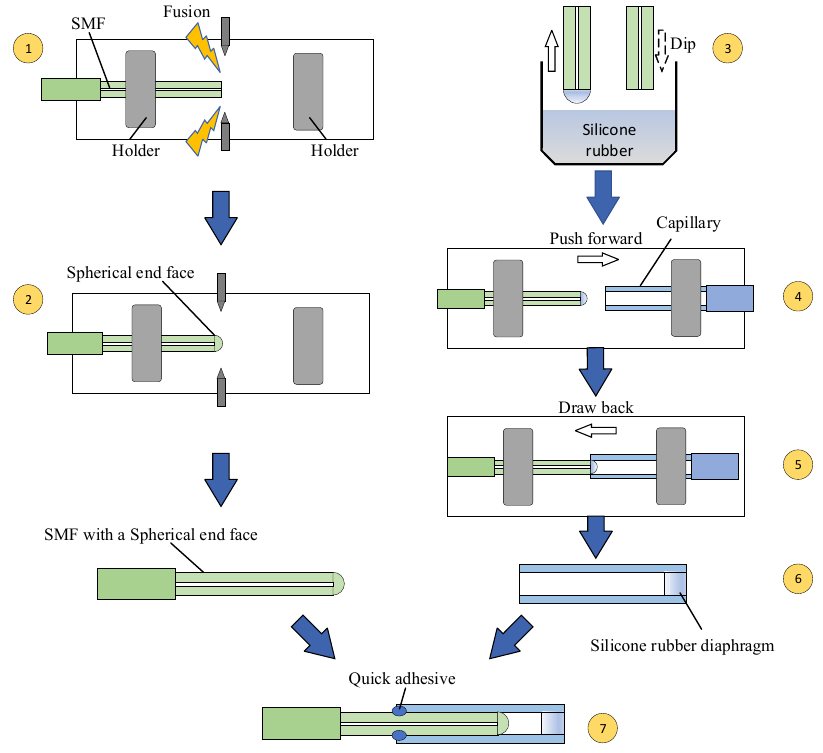
Figure 11. The fabrication process of proposed sensor.